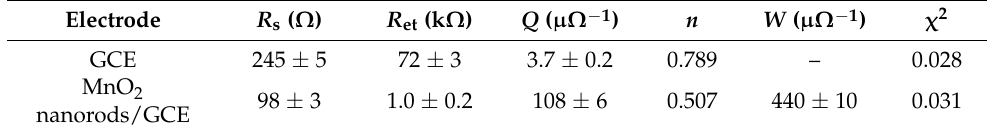
Table 2. Fitted parameters of the electrochemical impedance ( n = 5; p = 0.95).